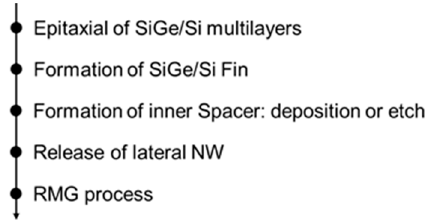
Figure 22. A manufacturing process of horizontal GAA-FETs (hGAA-FETs).